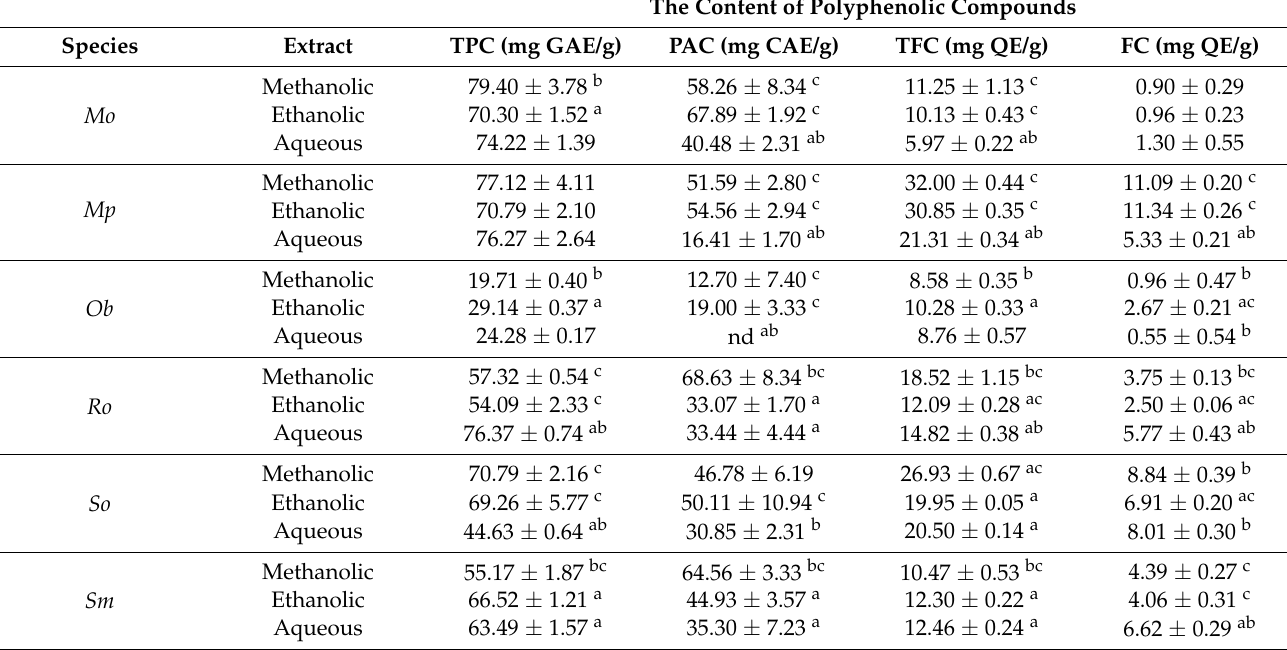
Table 1. The content of polyphenolic compounds (total phenolic (TPC), phenolic acid (PAC), total flavonoid (TFC), and flavonol (FC) contents) of the selected plant extracts presented at 250 µ g/mL, as means ± standard